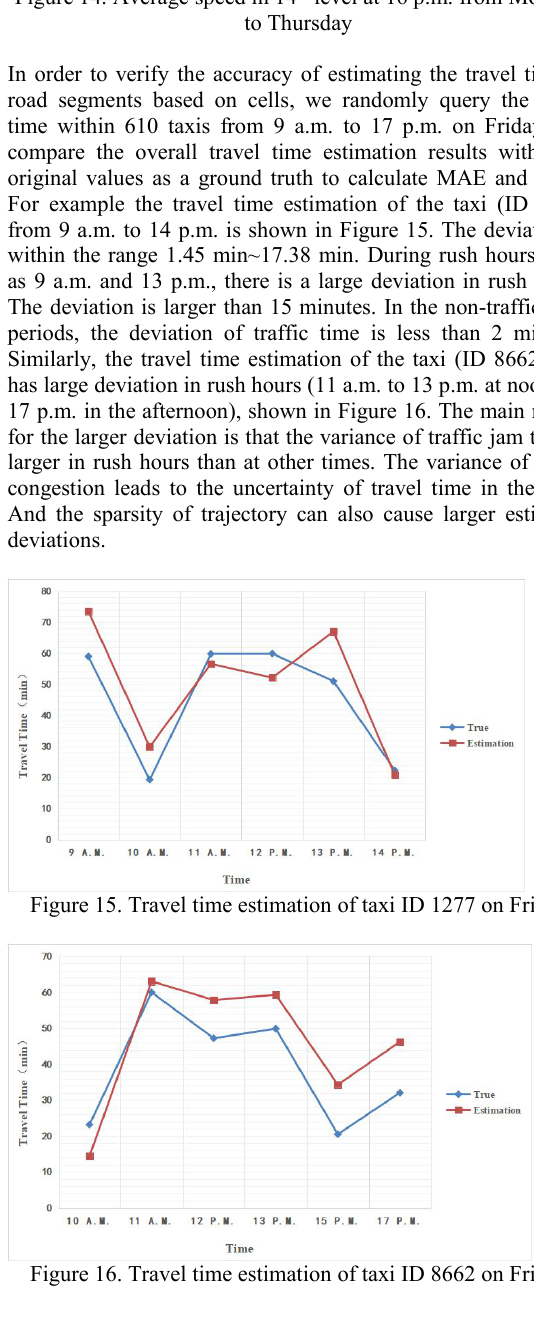
Figure 14. Average speed in 14 th level at 16 p.m. from Monday